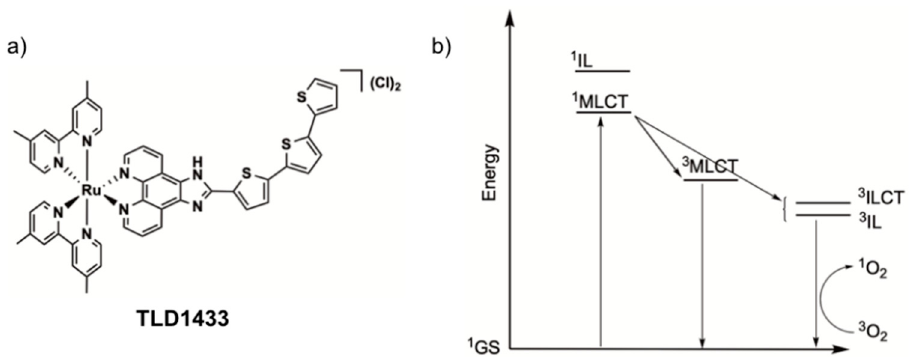
Figure 1. ( a ) Chemical structure of the PDT photosynthesizer TLD1433. ( b ) Jablonski diagram showing the formation of singlet oxygen ( 1 O 2 ) by irradiation of TLD1433 via initial population of metal-to-ligand charge transfer (MLCT) states and intersystem crossing to intra-ligand (IL, ILCT) states.